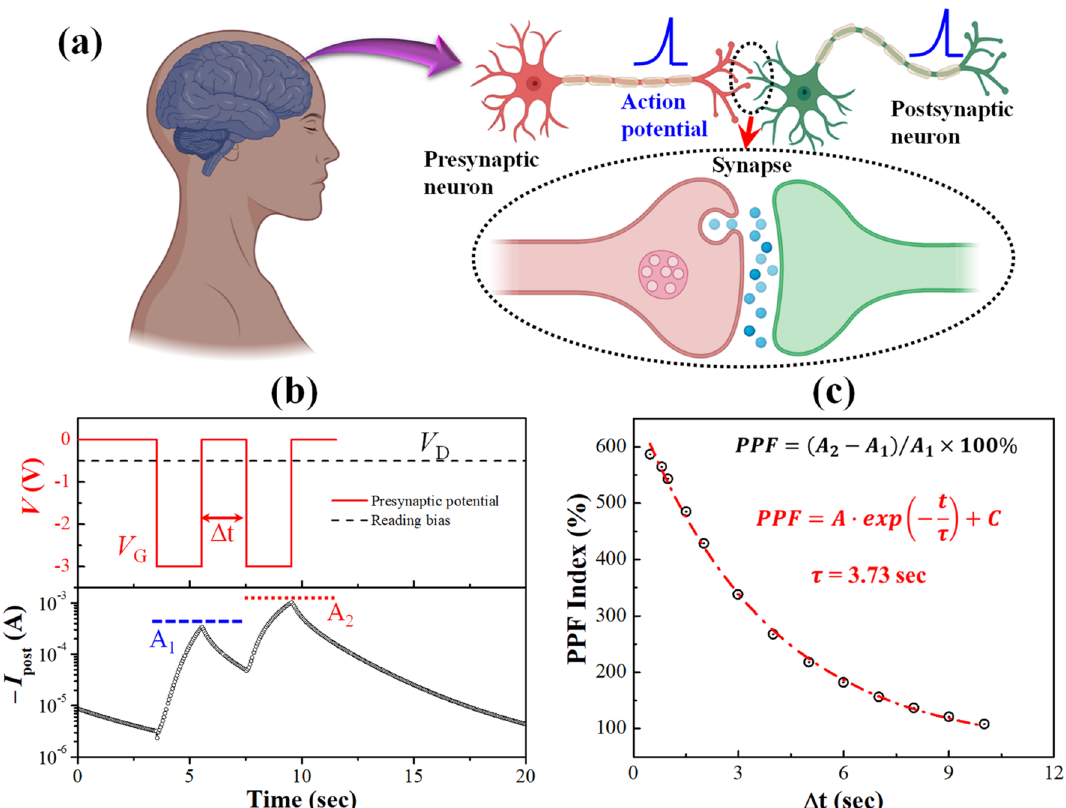
Figure 4. ( a ) Schematic representation of neural connectivity via synapse in a biological brain for the action potential transmission. ( b ) Short-term potentiation by applying a pair of presynaptic spikes ( V GS = − 3.0 V) with Δt of 2 s. Postsynaptic currents ( I post ) were recorded by biasing the drain at − 0.5 V. ( c ) Paired pulse facilitation (PPF) of the synaptic mem T devices obtained by varying the time interval Δt from 100 to 10